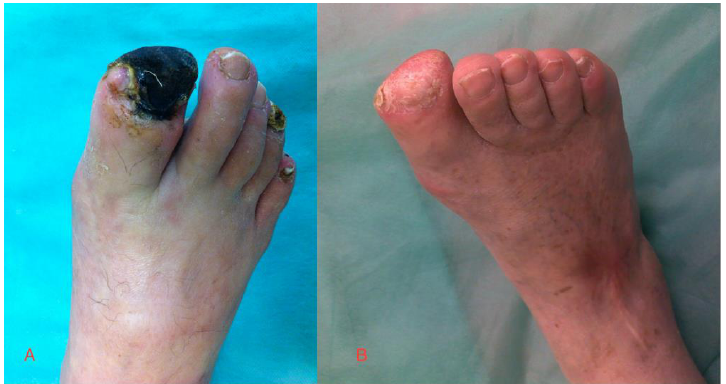
Figure 2. Toe necrosis in a Group 1 patient ( A ) before treatment and ( B ) after 3 months.